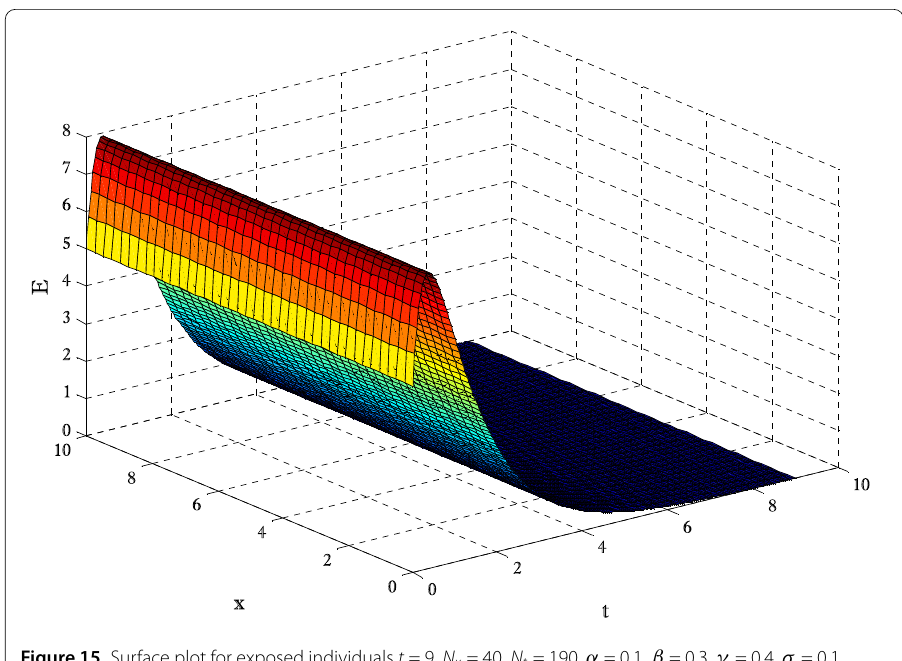
Figure 15 Surface plot for exposed individuals t = 9, N x = 40, N t = 190, α = 0.1, β = 0.3, γ = 0.4, σ = 0.1, μ = 0.4, d